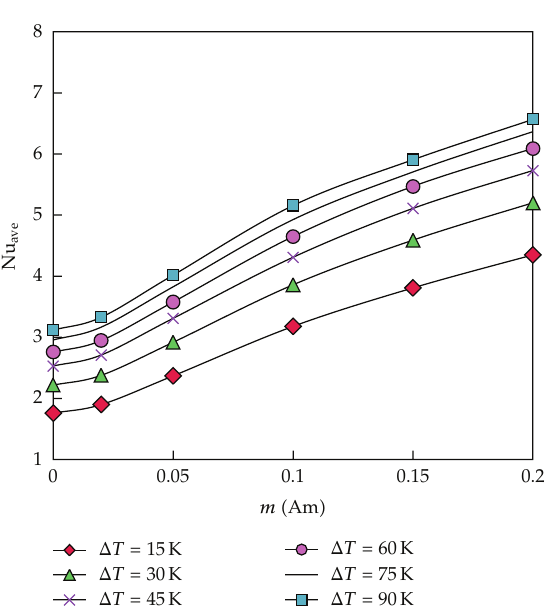
Figure 7: Average Nusslet number for di ff erent temperature di ff erence and magnetic field strength.